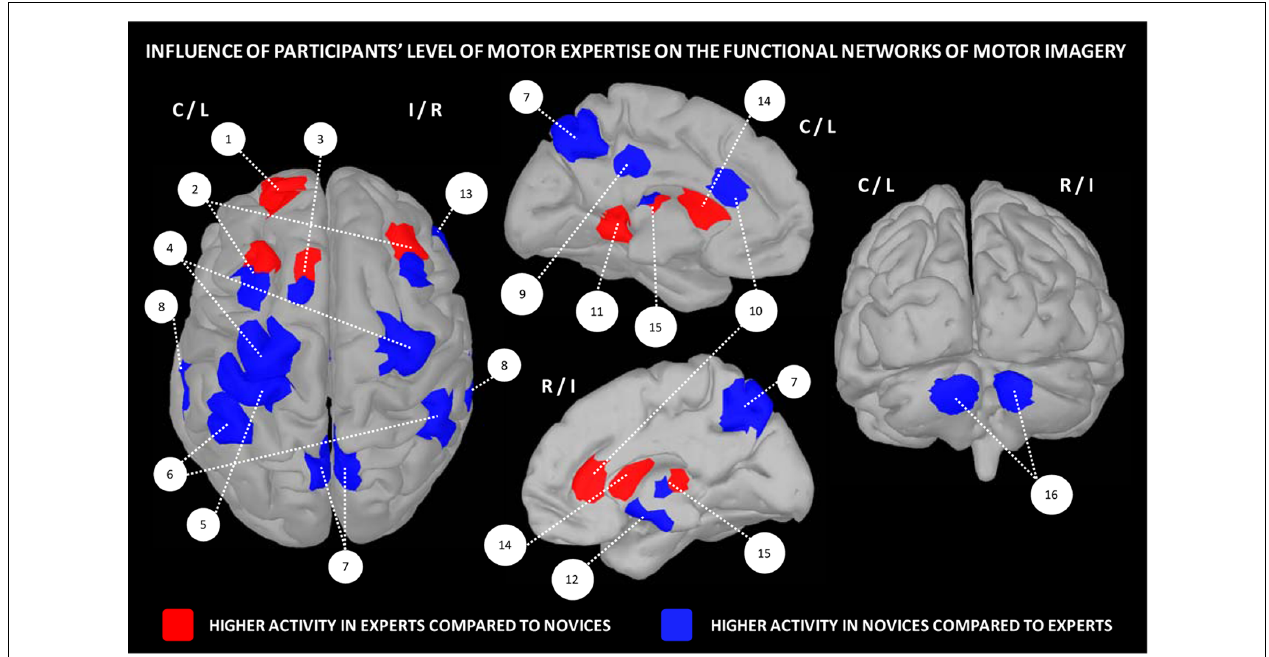
parahippocampal gyrus (BA36), 12 – hippocampus, 13 – insula/inferior frontal cortex, 14 – striatum, 15 – putamen, 16 – cerebellum (lobules IV/V region). Data were extracted from Lafleur etal. (2002), Lacourse etal. (2005), Milton etal. (2007), Olsson etal. (2008),Wei and Luo (2010), Chang etal. (2011), Baeck etal. (2012), Bezzola etal.